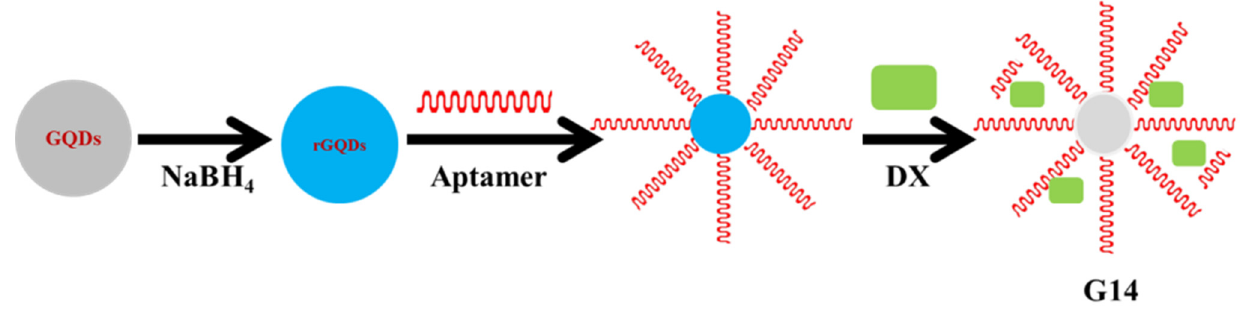
14 of 23 Figure 15. Schematic diagram of Campylobacter jejuni detection using the antibody GQDs/GO ( G13 ). Reprinted from [70] with permission from Elsevier. Faridbod and Ganjali et al. [71] synthesized a fluorescent apta-nanobiosenesor G14 with the help of rGQDs in connection with a biological fluid. Here, rGQDs were used as an optical probe, and a biological fluid digoxin (DX) aptamer was used as a sensing ele- ment. The synthesized G14 probe was allowed to interact with free biological aptamers, and caused fluorescence enhancement. Later, upon the addition of the targeted biological fluid DX molecule, G14 was bound with DX and resulted in a decreased fluorescence in- tensity (Figure 16). Reversibility was carried out using oxidized carbon nanotubes with G14 -DX complexation aptamers through FRET. Upon the addition of DX into the ap-